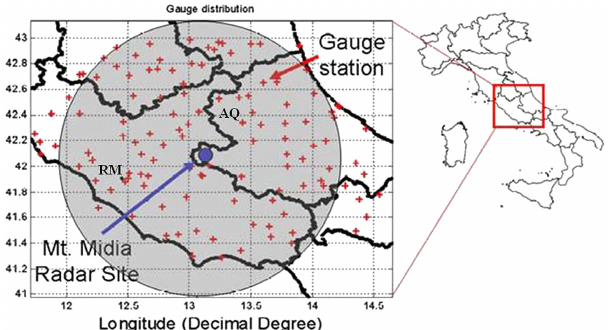
Figure 3. The panel shows the location of the Monte Midia radar between the Abruzzo (to the right) and Lazio (to the left) regions, its coverage (gray circle), and the rain gauge network (red crosses) used for calibration of the estimated